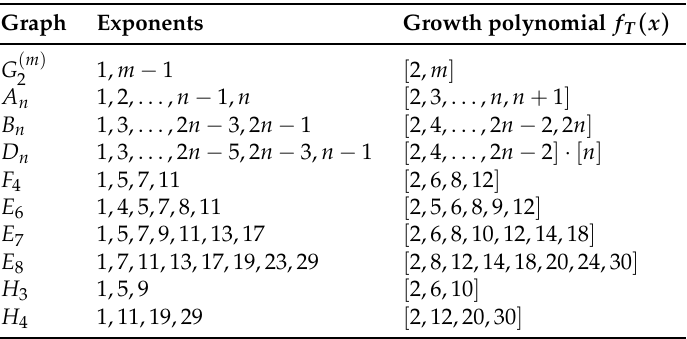
Table 2. Exponents and growth polynomials of irreducible finite Coxeter groups Γ T